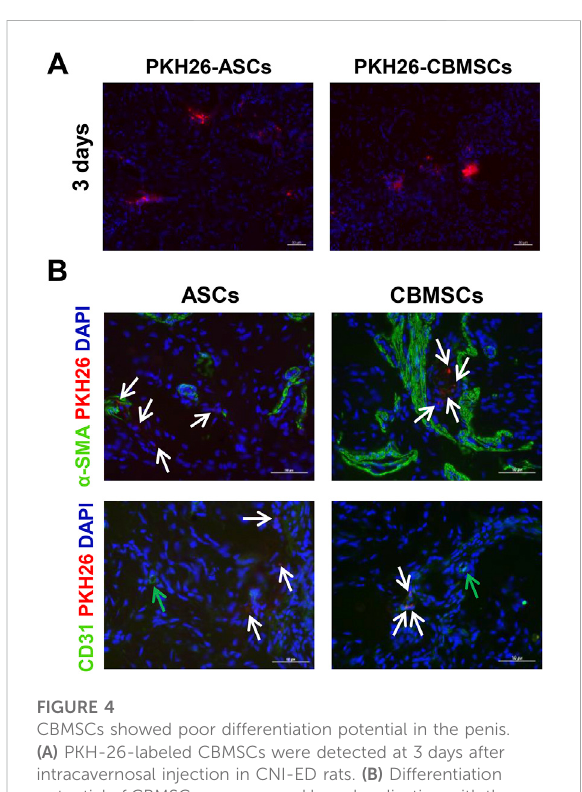
FIGURE 4 CBMSCs showed poor differentiation potential in the penis. (A) PKH-26-labeled CBMSCs were detected at 3 days after intracavernosal injection in CNI-ED rats. (B) Differentiation potential of CBMSCs was assessed by colocalization with the CCSMC marker and CD31 marker. White arrows: PKH-26-labeled CBMSCs or ASCs. Green arrows: CD31-positive endothelial